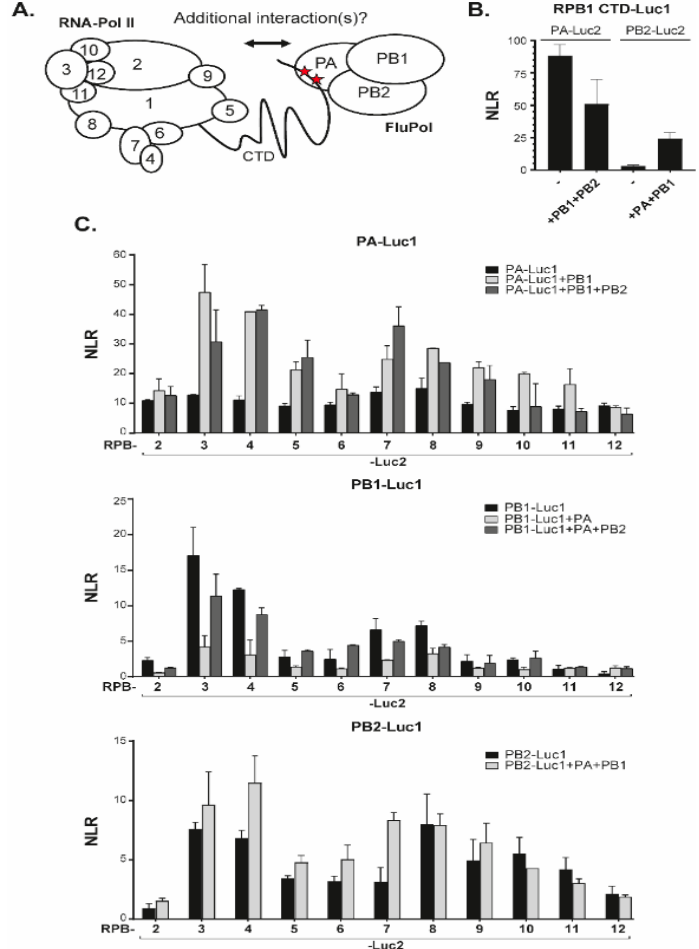
Figure 2. Split-luciferase assays between FluPol and Pol II subunits. ( A ) Schematic of FluPol and Pol II with their subunits and the interaction between the CTD of Pol II with FluPol. Red stars indicate the YSPTSpPS CTD motif (with the phosphorylated Serine 5). ( B ) A plasmid encoding a CTD stretch of RPB1 fused the Luc1 moiety was co-transfected with plasmids encoding PA or PB2 fused to the Luc2 moiety. Plasmids encoding untagged PA, PB1, or PB2 were also added when indicated to produce complete FluPol. Twenty-four hours post-transfection, cells were lysed and luminescence signal was measured. ( C ) Pairs of plasmids encoding a Luc1-FluPol subunit with a Luc2-Pol II subunit were transfected into HEK 293T along with/without untagged FluPol subunits. NLR signals were quantified as described in Figure 1B. Data are mean ± s.d. n = two technical replicates representative of two or three independent